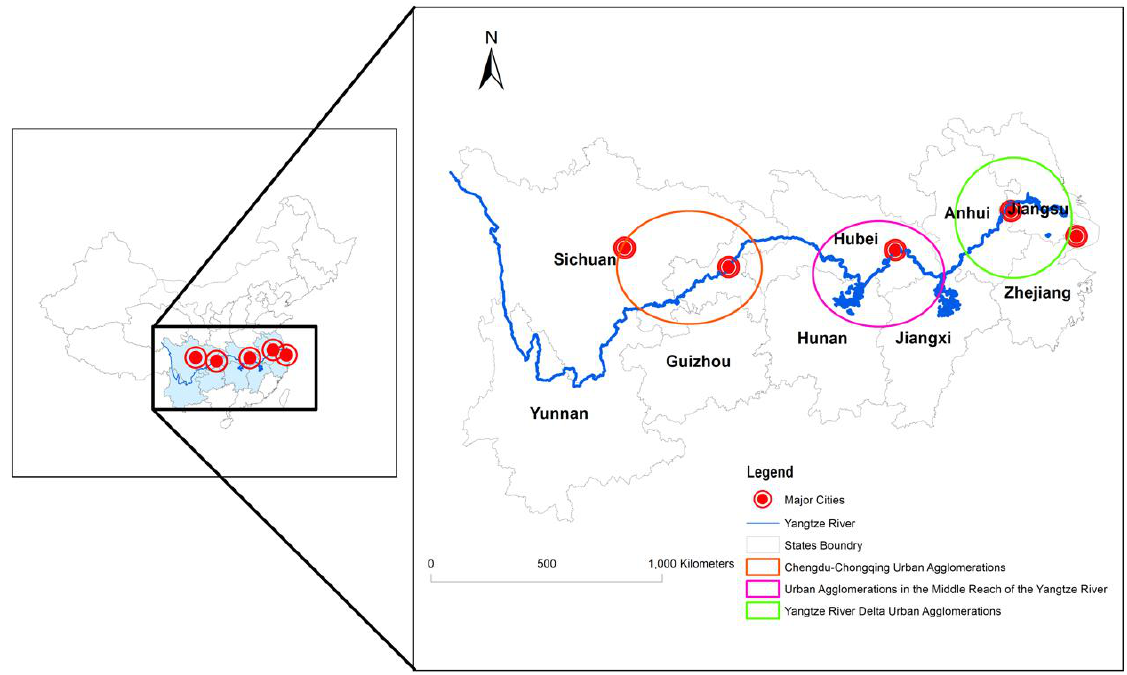
Figure 3. Geographical scope of the